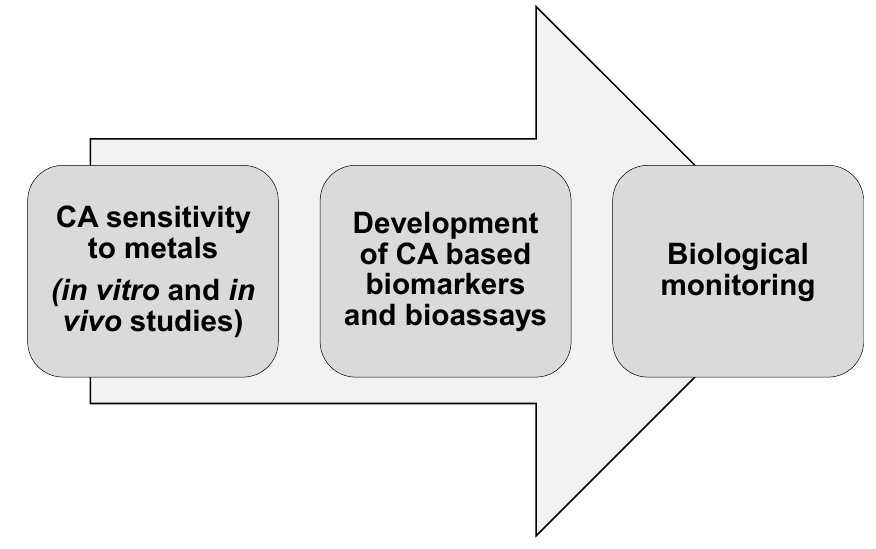
Figure 3. From in vivo and in vivo assessment of the sensitivity of CA to trace metals to environmental monitoring.